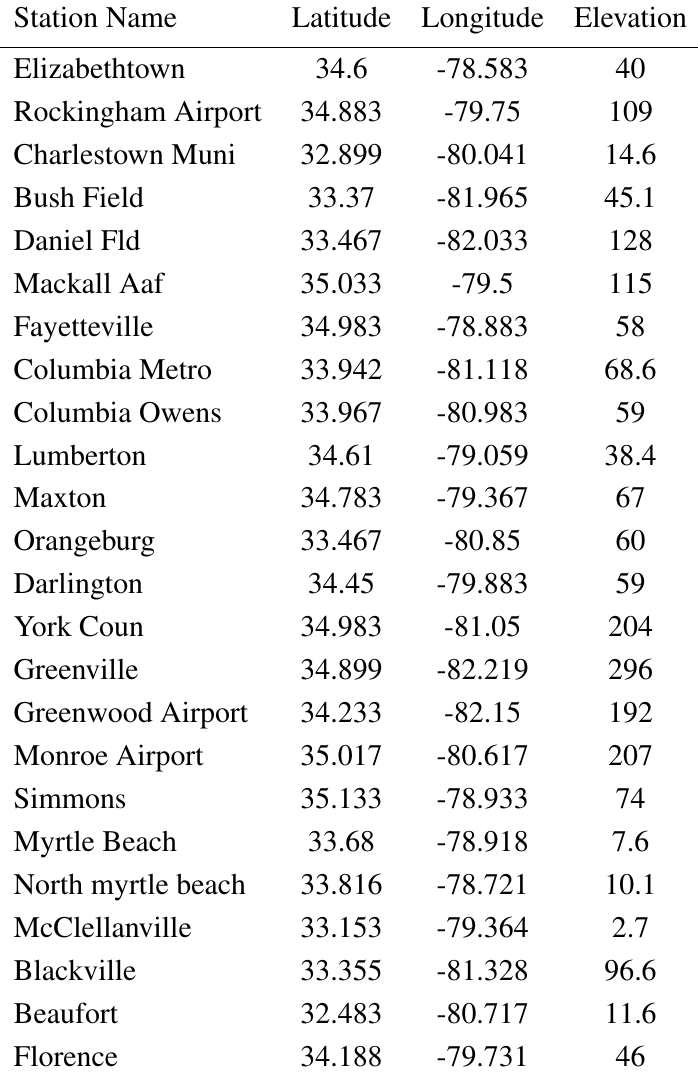
Table 1. Selected rain gauge